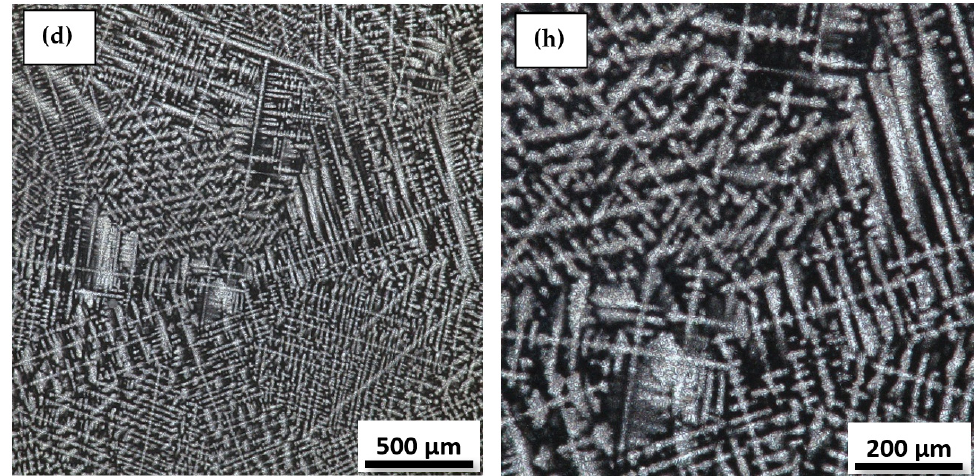
Figure 6. Microstructure analysis of Ti20Mo7Zr15Ta alloys with different percentages of Si added at a magnifying power of Ti20Mo7Zr15Ta0.5Si, ( g ) Ti20Mo7Zr15Ta0.75Si, ( h ) Ti20Mo7Zr15Ta1Si.